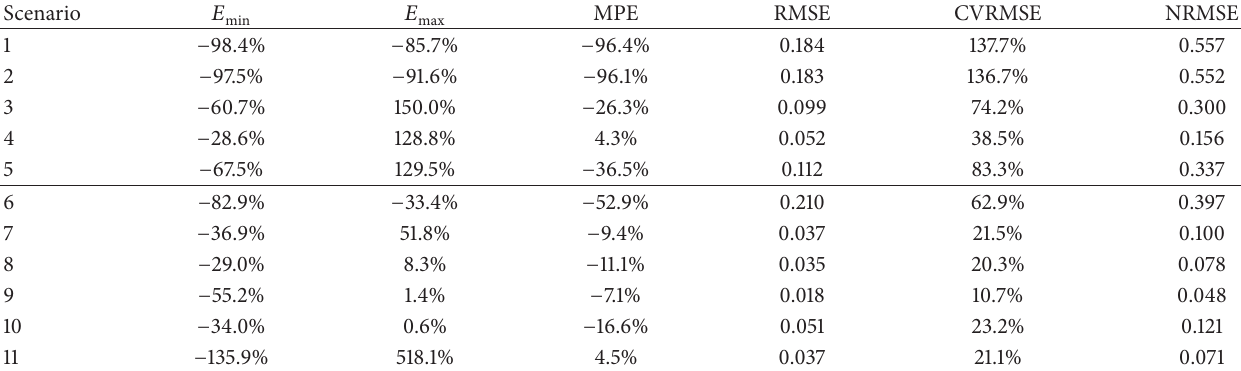
Table 5: Values of the statistical measures of the studied